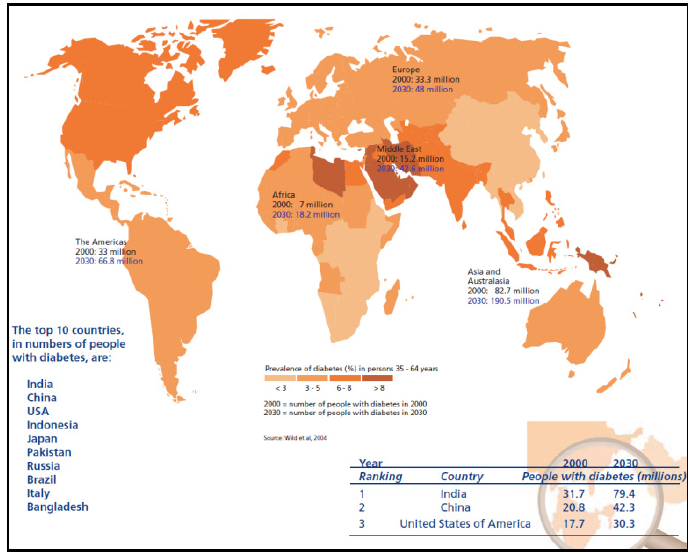
Figure 2. Alarming diabetes spread worldwide (Source: World Health Organization,